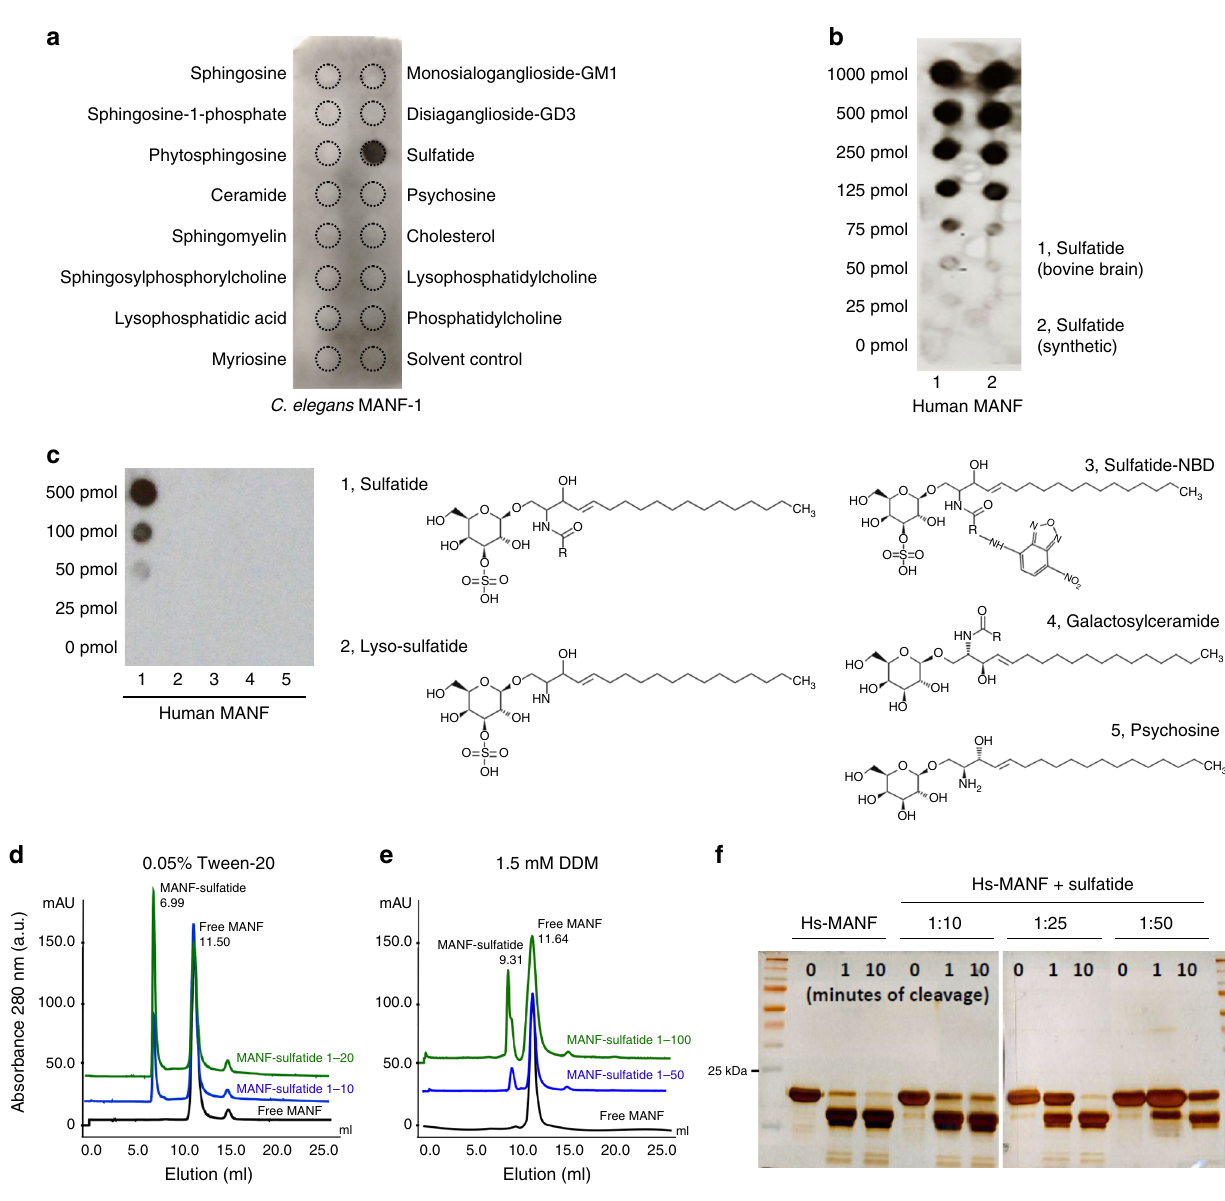
Fig. 2 Puri fi ed MANF binds to sulfatide. a Lipid overlay assay with an Echelon Sphingostrip membrane showing speci fi c binding of His-tagged Ce-MANF to sulfatide. b Lipid overlay assay with customized lipid membrane showing dose-dependent binding of His-tagged Hs-MANF to sulfatide, prepared from bovine brains or synthetic source. c Lipid overlay assay with customized lipid membrane spotted with sulfatide-related lipids showing that sulfate as well as both acyl chains moieties are required for the sulfatide::Hs-MANF interaction. d Size exclusion chromatography with Hs-MANF reconstituted in 0.05% Tween-20 and varying doses of sulfatide. Molar ratio of MANF:Sulfatide at 1:20 was suf fi cient for 50% fraction to be bound onto tween-sulfatide micelles (peak at 6.99ml elution). e Size exclusion chromatography with Hs-MANF reconstituted in 1.5 mM dodecyl maltoside (DDM) and varying doses of sulfatide. Molar ratio of MANF:Sulfatide at 1:100 resulted in 40% protein fraction to be bound onto DDM-sulfatide micelles (peak at 9.31 ml elution). f Limited proteolysis using trypsin protease showing that Hs-MANF is protected against digestion upon sulfatide binding, under conditions of different cleavage times (0, 1, and 10 min) and MANF versus sulfatide molar ratios (1:10, 1:25, and